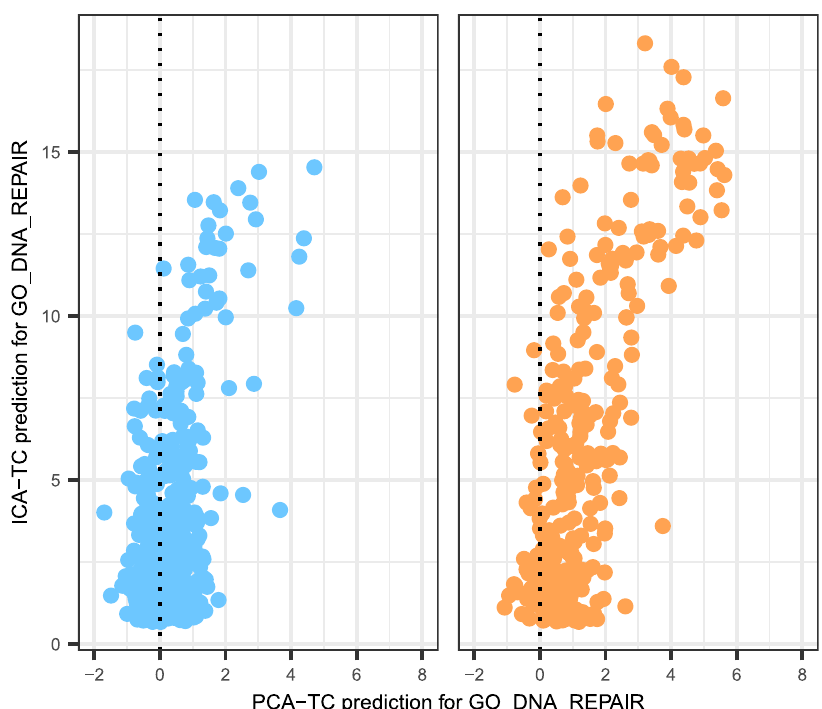
Fig. 7 Predictions scores for genes found to be essential for DNA repair in a CRISPR-based screen. Both the PCA-TC and ICA-TC-based method predictions for Gene Ontology Biological Process gene set GO DNA REPAIR are shown. Genes that belong (orange) or do not belong (blue) to the GO DNA repair gene set are plotted in separate panels. For the case of genes that are not members of a DNA repair gene set, the scatterplot indicates that ICA-TC- based predictions are higher, while PCA-TC-based predictions remain close to zero and are sometimes